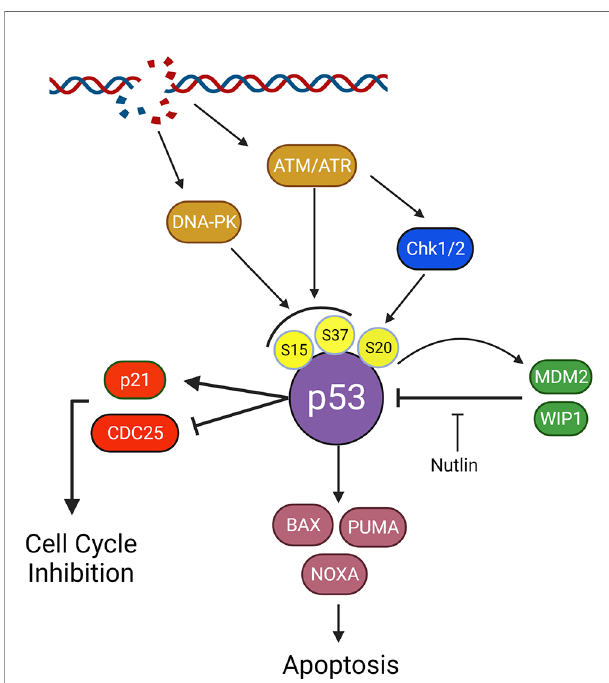
FIGURE 4 | Impact of p53 on survival and p53 signaling in the DNA damage response. P53 is a downstream effector following double strand DNA breaks and plays a crucial role in tumorigenesis. Following Damage detection by ATM/ATR or activation of DNA-PKcs, p53 is phosphorylated at Ser15 or Ser37. ATM and ATR will also activate Chk1 and 2 resulting in phosphorylation of p53 at Ser20. Together these phospho-sites inhibit p53 degradation by preventing MDM2 binding and facilitate p53 tetramerization, a crucial step in p53 activation. p53 will activate p21 and inhibit CDC25 A, B, and C to activate the cell cycle checkpoint and inhibit cycling. p53 will also transcriptionally upregulate pro-death proteins, BAX, PUMA, and NOXA. Upon overcoming inhibition by BCL-2 family apoptotic inhibitors (not shown), BAX, PUMA, and NOXA will activate apoptosis. Inhibition of the MDM2-p53 interaction with nutlin allows for p53 accumulation and apoptosis, ideally in cells heavily reliant on p53 suppression for